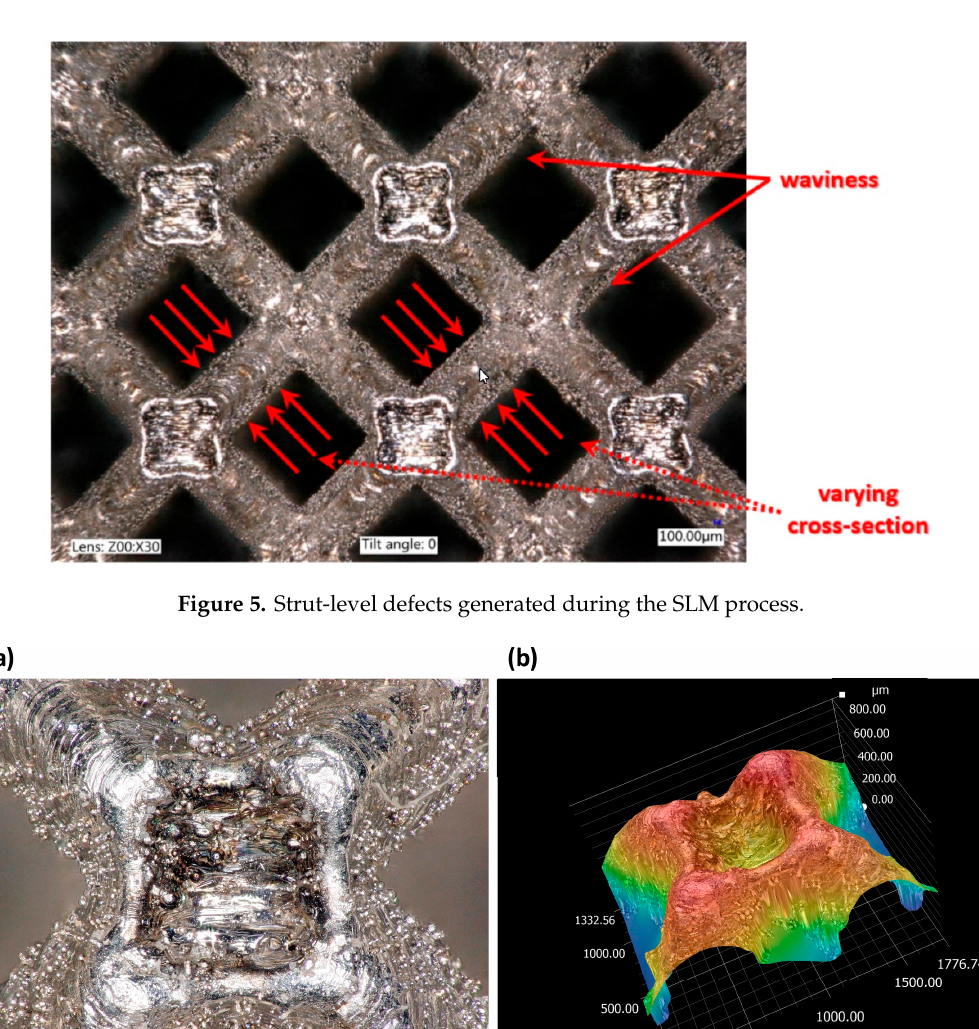
Figure 7. Computed tomography (CT) images of the SLM lattice structure. 2.3. Microstructure and Phase Composition The microstructure of the 316L stainless steel lattice structures manufactured using the SLM technique was described in detail in the authors’ earlier work. Some defects such as pores, incomplete